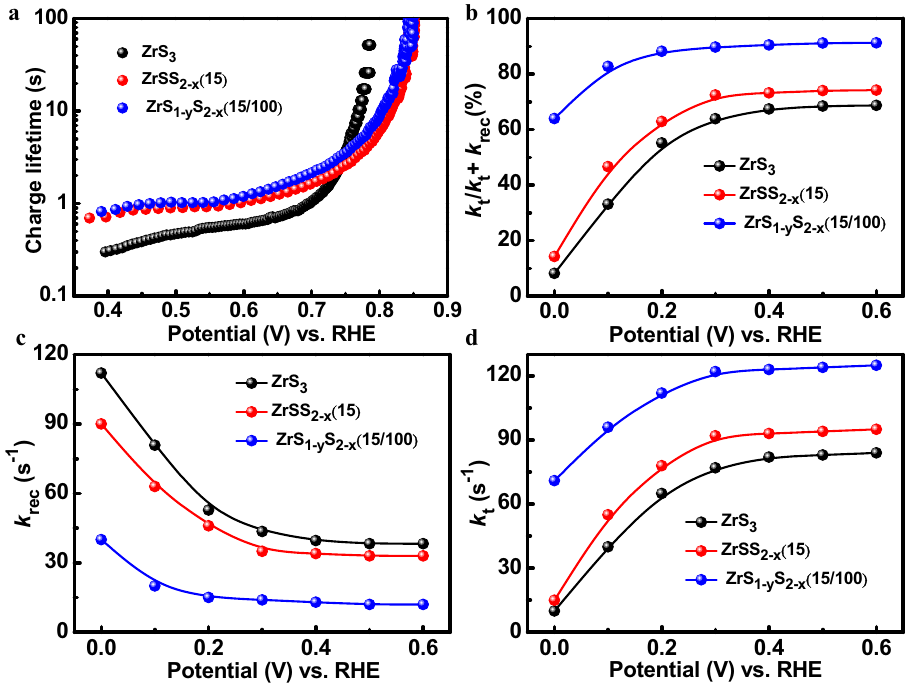
Fig. 5 The charge carrier dynamics of the photocatalysts. a The charge carrier lifetime of ZrS 3 , ZrSS 2-x (15), and ZrS 1-y S 2-x (15/100) NBs. b Ratio of k t /( k t + k k k rec ), rate constants c t and d rec of ZrS 3 , ZrSS 2-x (15), and ZrS 1-y S 2-x (15/100) for benzylamine oxidation measured in 0.5 M Na 2 SO 4 with 0.1 M